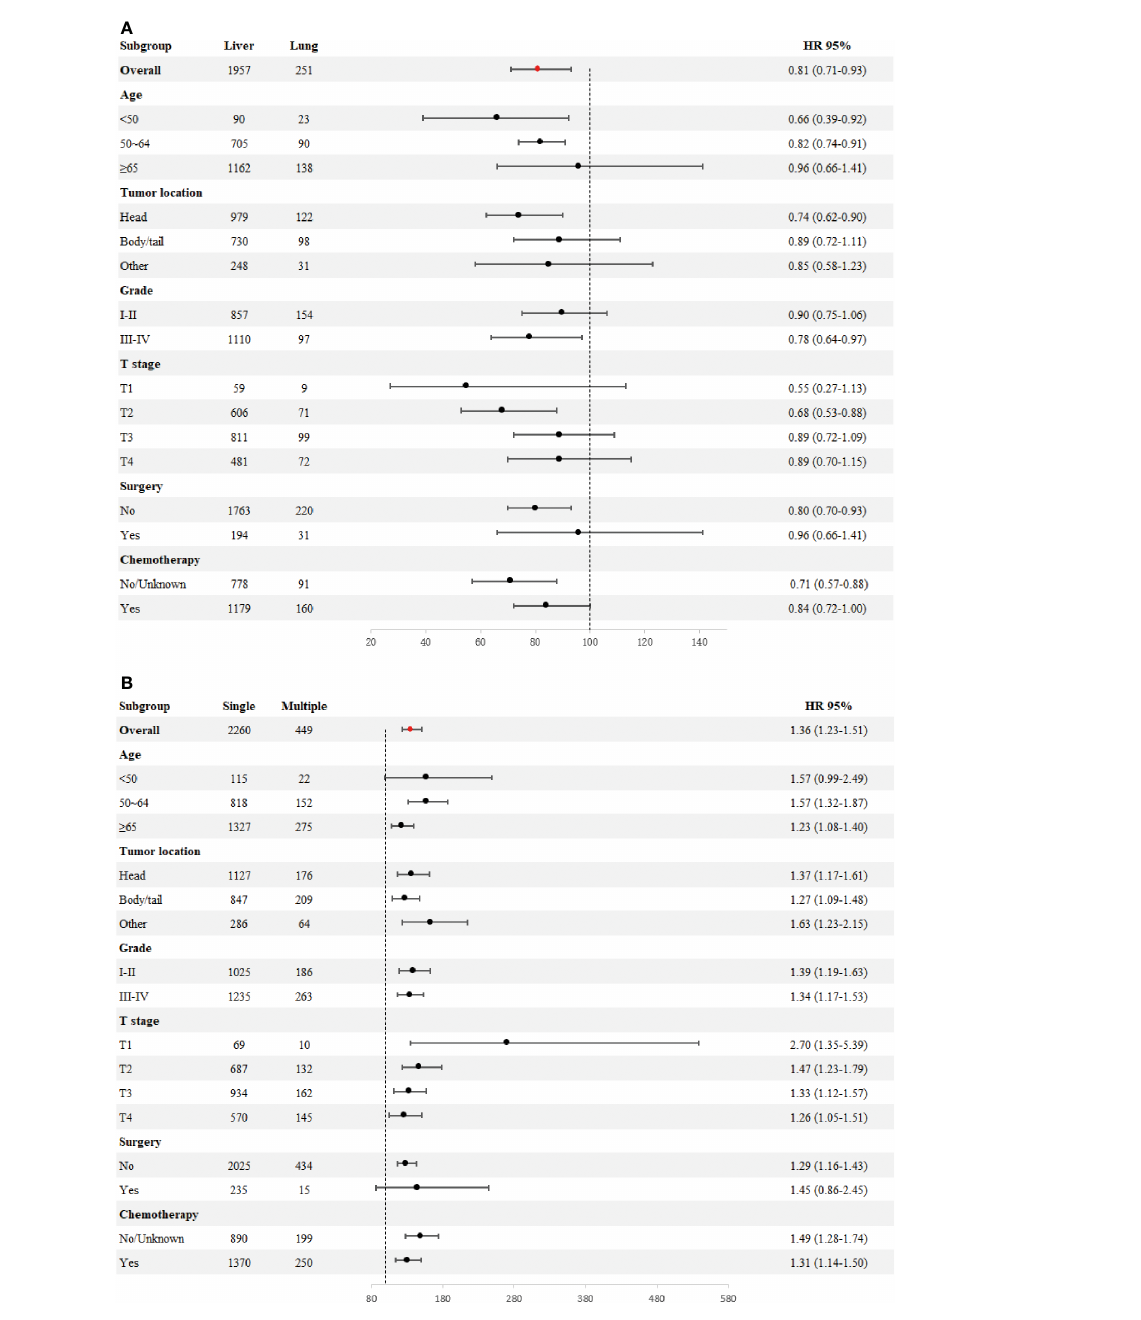
FIGURE 2 Forest plot for subgroup analysis of the sites of distant metastases (A) . Forest plot for subgroup analysis of the number of distant metastases (B)